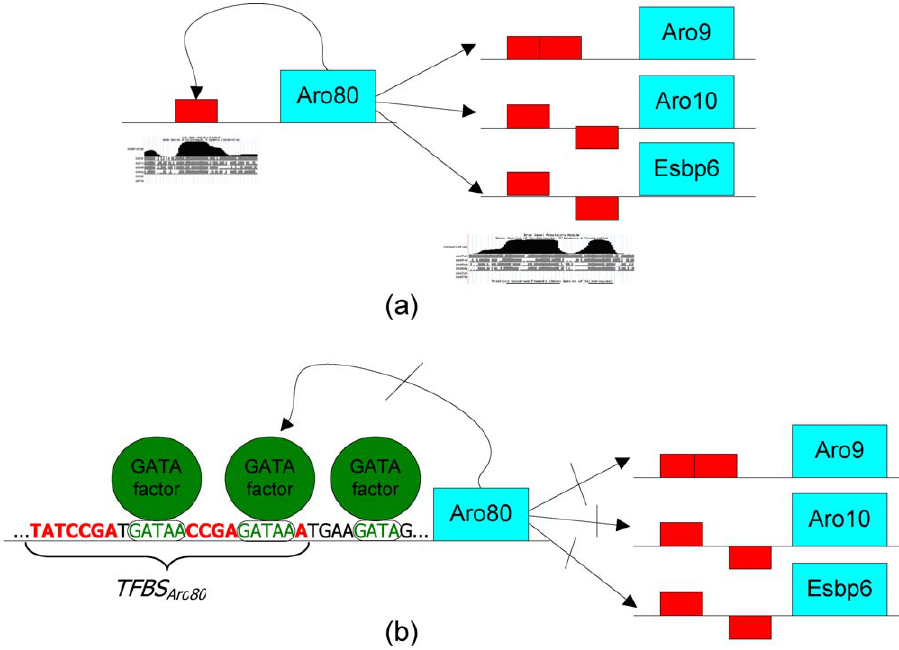
Figure 4. The Hypothetical Regulatory Network of Aro80 Copies of the BS Aro 80 motif (on the sense and antisense) are shown as rectangles on the promoter regions. (A) BS Aro 80 is conserved in four strains of yeast as shown using the University of California Santa Cruz browser conservation plots. Aro80 regulates the utilization of secondary nitrogen sources such as aromatic amino acids by binding genes that participate in the catabolism of aromatic amino acids. We hypothesize that it also binds to its own promoter region and introduces a positive feedback self loop. (B) Part of the Aro80 promoter sequence is shown with bases of the BS Aro 80 motif colored in red. Interestingly, there are three GATA binding sites that are adjacent to the BS Aro 80 motif (bases colored in green). These sites bind GATA factors that are known to play a role in nitrogen catabolite repression. We hypothesize that they are also involved in the repression of Aro80 expression by physically binding to the region near BS Aro 80 , thus making it inaccessible to Aro80 binding. This in turn breaks the positive feedback loop and represses the expression of Aro80 itself and other Aro80 regulated genes.